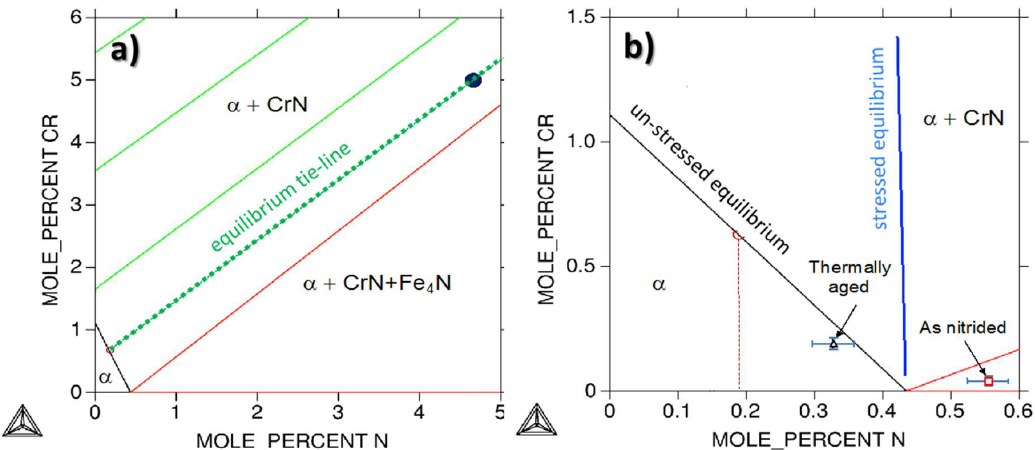
Figure 14. Isothermal sections of the ternary Fe–Cr–N phase diagram at 590 °C. ( a ) Nitrogen and chromium contents in the ferritic matrix in equilibrium with CrN are set by the tie-line running through the alloy composition. ( b ) The solvi of CrN in ferrite, under stress and stress-free, are represented along with nitrogen and chromium concentrations in ferrite after nitriding and after annealing in vacuum for 24 h at 590 °C.